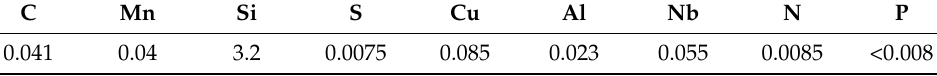
Table 1. Chemical compositions of grain-oriented silicon steel (wt.%).